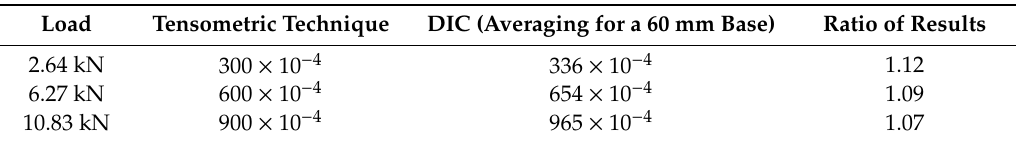
Table 4. Linear vertical strains (machine direction)—polyester geogrid; average values of strains from 5 samples [52].